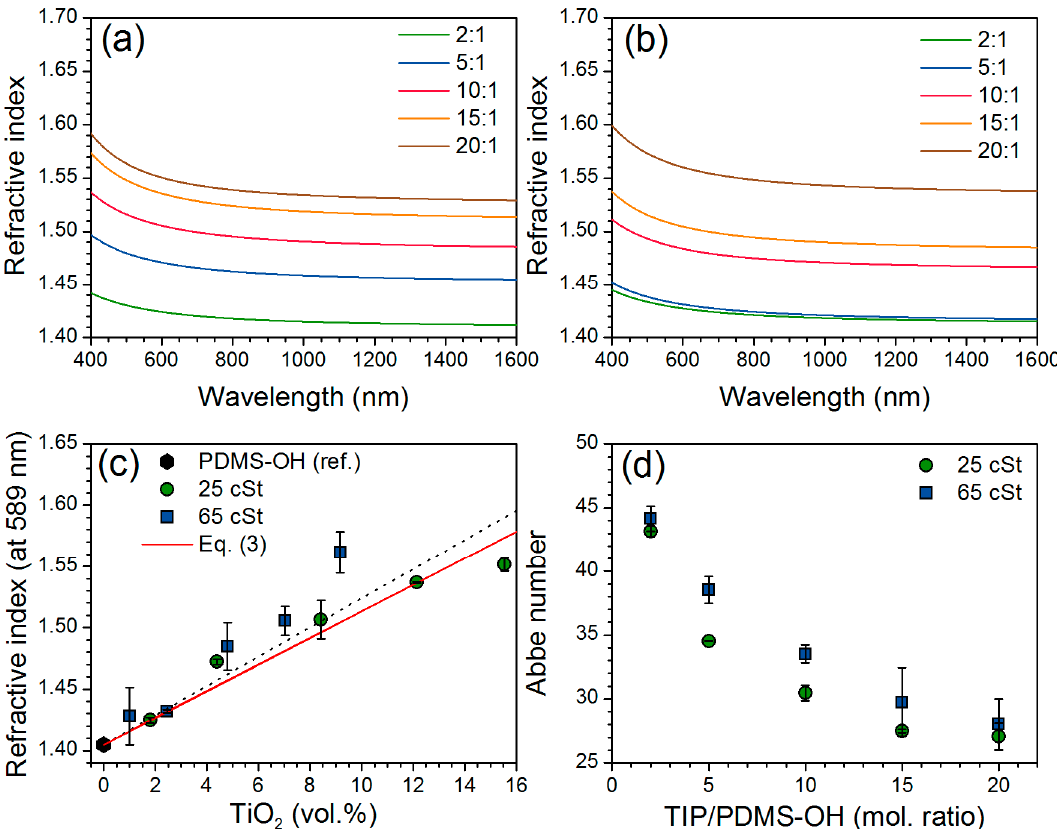
Figure 8. Average refractive index of spin-coated Ti-PDMS hybrid films prepared using PDMS-OH with viscosities of ( a ) 25 cSt, ( b ) 65 cSt for different TIP/PDMS-OH molar ratios, ( c ) refractive index at 589 nm as a function of the TiO 2 vol. % of the hybrid materials with linear regression (reference point at 0 vol. % TiO 2 is given by the PDMS-OH manufacturer) and comparison with Equation (3) and ( d ) Abbe number of spin-coated Ti-PDMS hybrid films as a function of the TIP/PDMS-OH molar ratio.